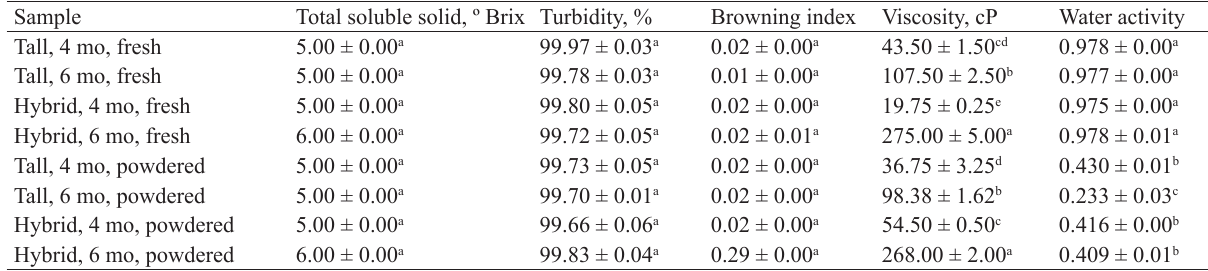
Table 3 Physical characteristics of fresh and powdered coconut drinks (mean ± SD)